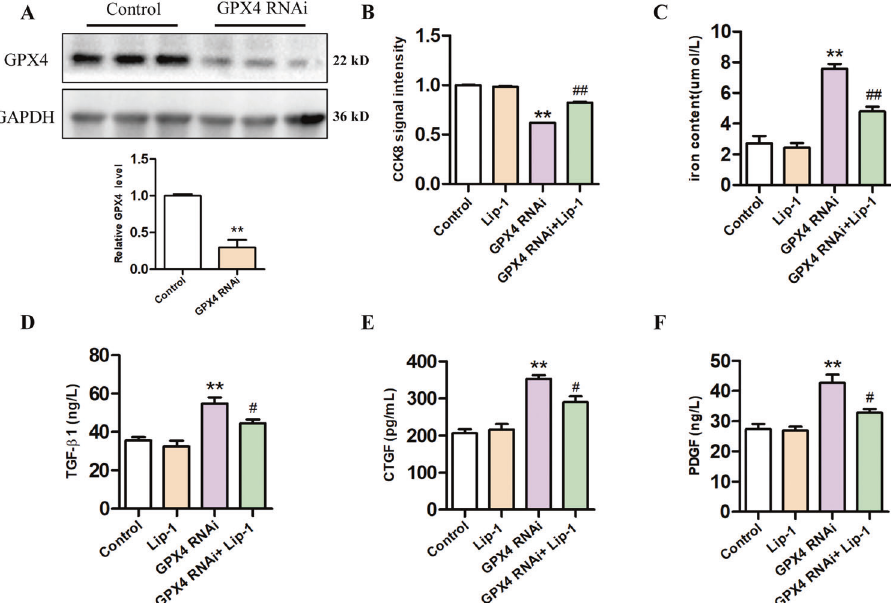
Fig. 6 Effects of Liproxstatin-1 on GPX4 knockdown-induced HK2 cells ferroptosis and pro fi brotic factor secretion. A Protein expression of GPX4 in renal tissues of mice was detected by western blotting ( n = 3, ** P < 0.01 vs control group). B Viability of HK2 cells, evaluated by the CCK-8 assay ( n = 5, ** P < 0.01 vs control group; ## P < 0.01 vs GPX4 RNAi group). c Iron concentrations in HK2 cells ( n = 3, ** P < 0.01 vs control group; ## P < 0.01 vs GPX4 RNAi group). D – F TGF- β 1, CTGF, and PDGF levels in the HK2 cells supernatant ( n = 3, ** P < 0.01 vs control group; # P < 0.05 vs GPX4 RNAi group). The data are presented as the mean ± SD.